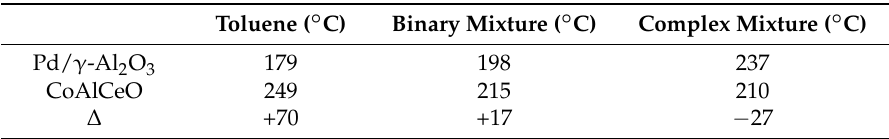
Figure 9. Abatement curves of the complex mixture on Pd/ γ‐ Al 2 O 3 and CoAlCeO catalysts. Table 9. T 50 of Pd/ γ‐ Al 2 O 3 and CoAlCeO catalysts for toluene, binary mixture, and complex mixture total oxidation.